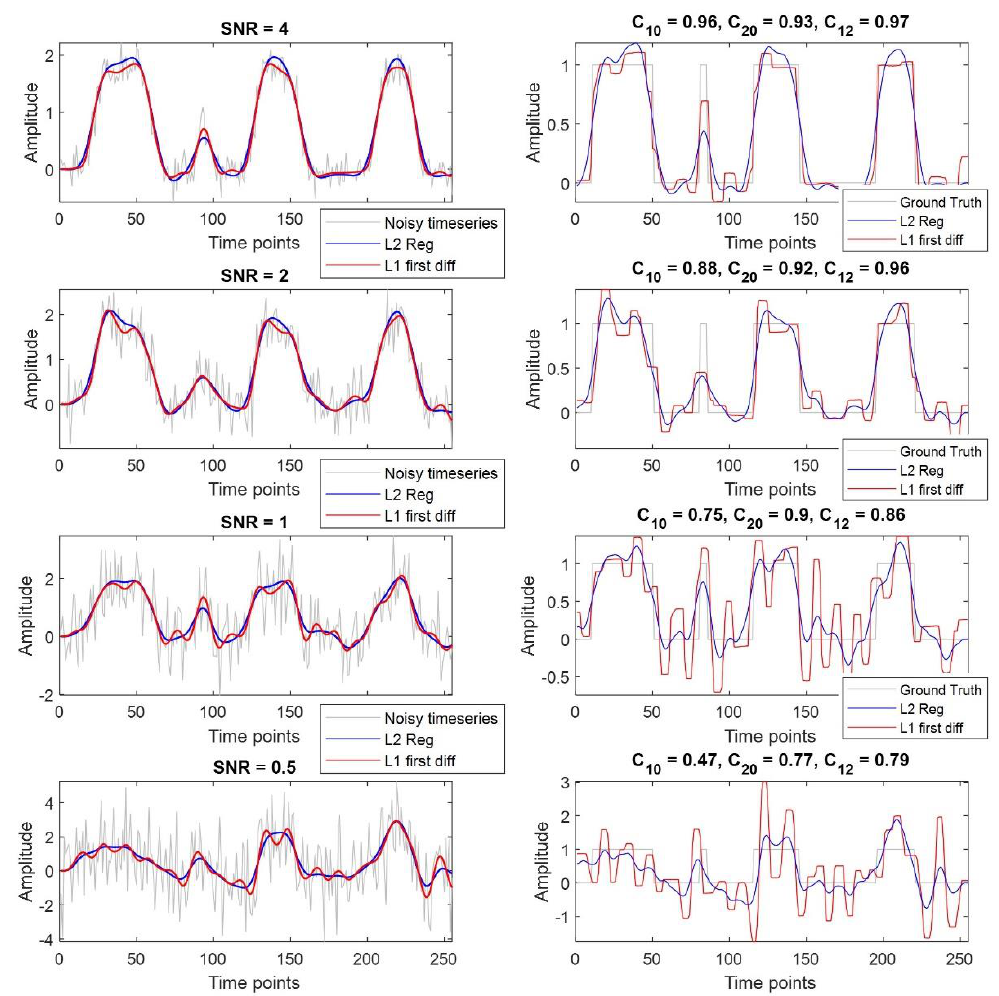
Figure A7. Comparison of L1 of the first difference and L2 regularization on synthetic time series data. Left column subplot shows synthetic noisy time series (grey) with reconstruction using different regularization shown in red (L1 first difference) and blue (L2). Right column subplots show the round truth experiment design (grey) with the estimated pseudo-stimulus using different regularization shown in red (L1 first difference) and blue (L2). Each row subplot corresponds to a different SNR value indicated in the title of the left subplots.